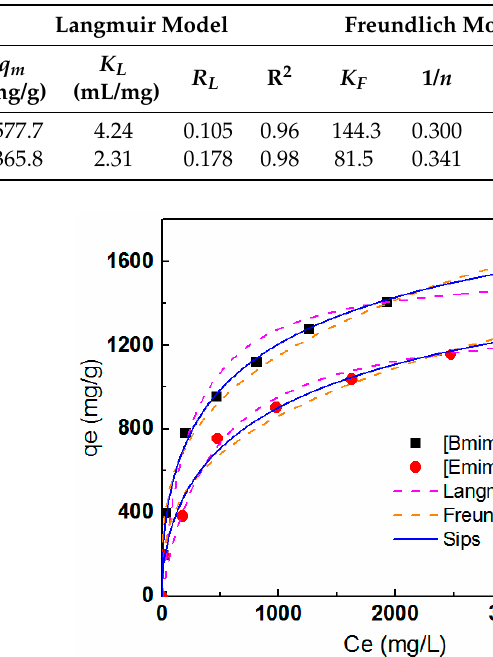
Table 4. Fitting parameters of isotherms (Langmuir, Freundlich, and Sips models) for adsorption of